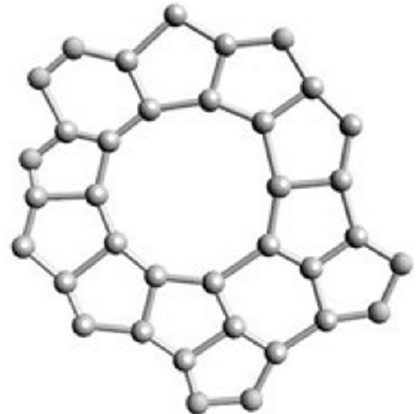
Figure 10. Schematic drawing of synthetic ZSM-5 zeolite. Reprinted from Reference [84], with permission from Elsevier.